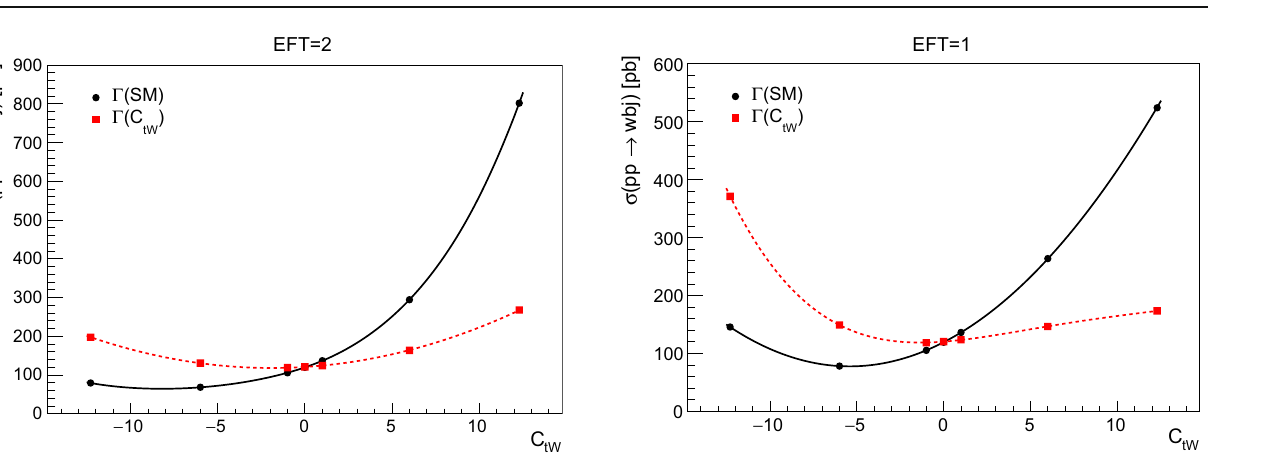
Fig. 8 The cross section of Wbj production as a function of C tW with one insertion with the width of the top fixed to the SM value (quadratic behaviour) or computed according to the value of the operator (higher- order polynomial)